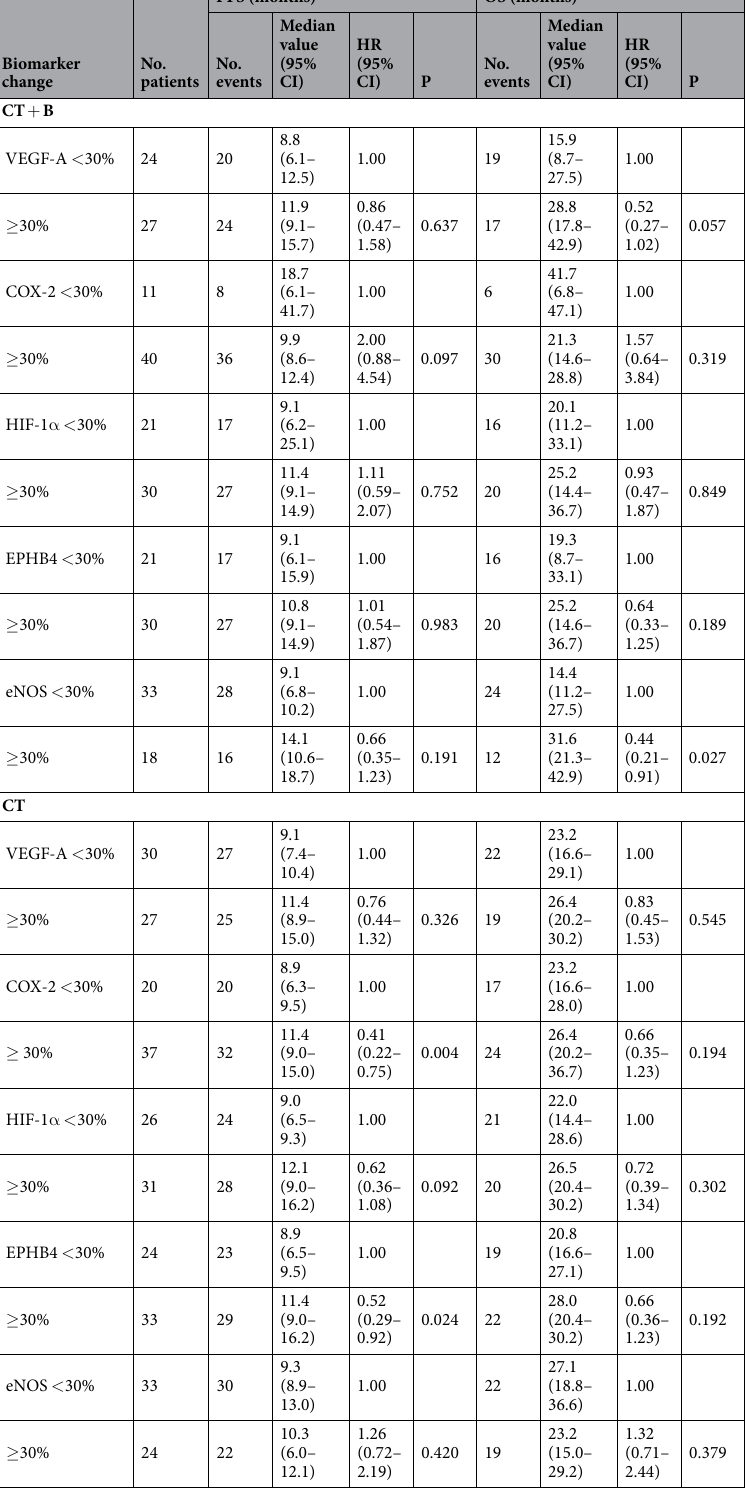
Table 2. PFS and OS with respect to changes in biomarker levels from baseline to first clinical evaluation. PFS, progression-free survival; OS, overall survival; CT, chemotherapy; B, bevacizumab; HR, hazard ratio; CI, confidence